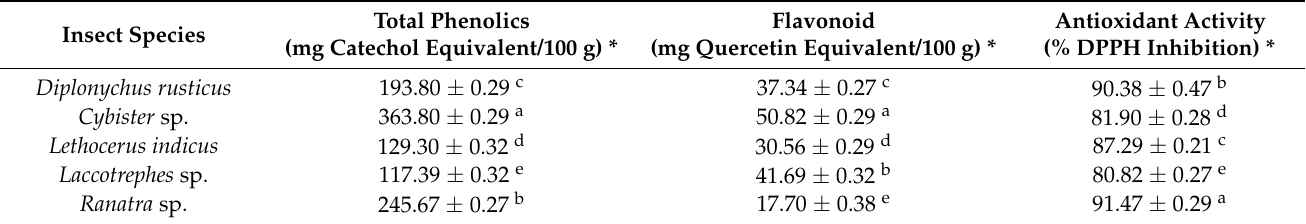
Table 4. Antioxidant properties of five aquatic insect species (d.w.) 1 .